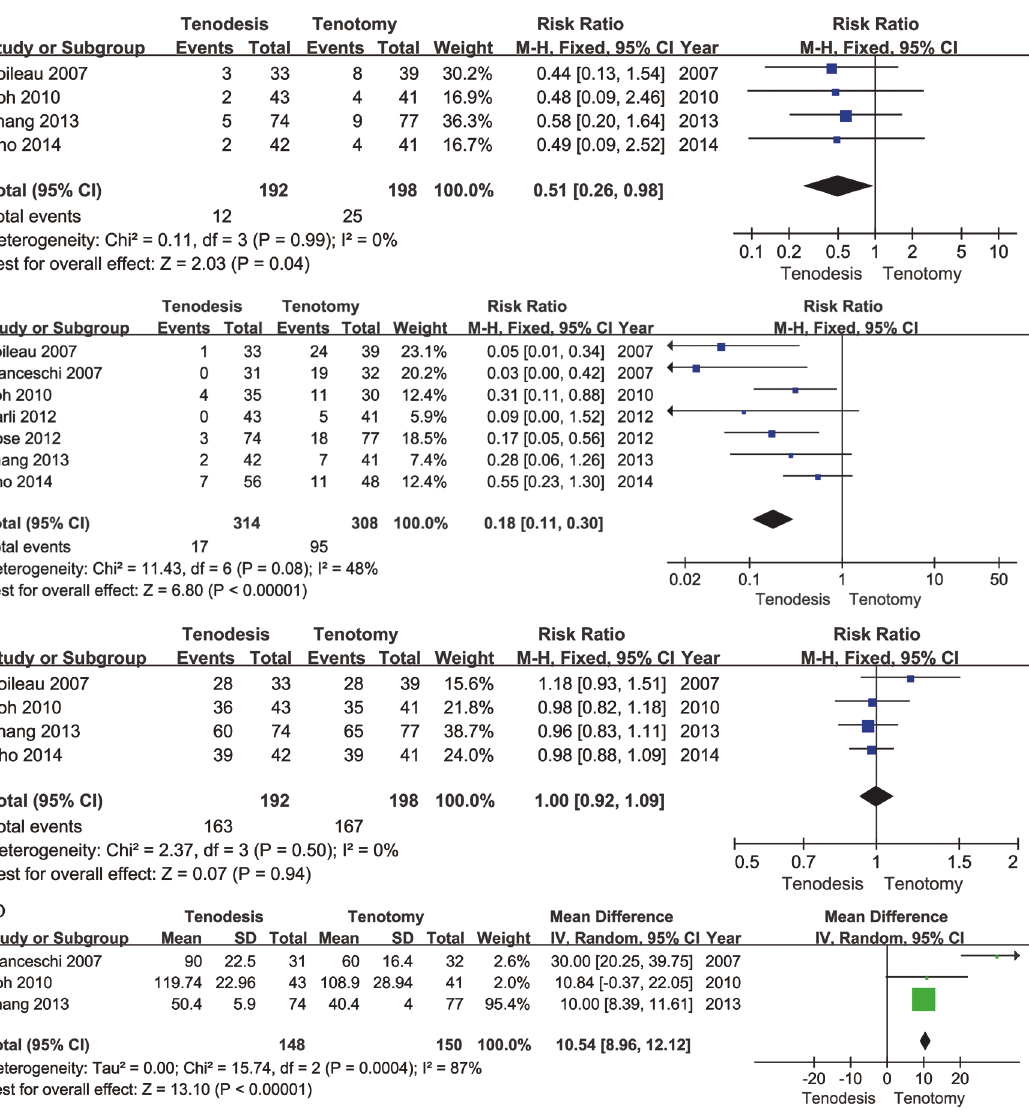
Fig 3. Secondary outcomes after meta-analysis. A Forest plot to assess cramps pain events between two treatment strategies. B Forest plot to assess Popeye sign events between two treatment strategies. C Forest plot to assess patient ’ s satisfaction events between two treatment strategies. D Forest plot to assess surgical time events between two treatment